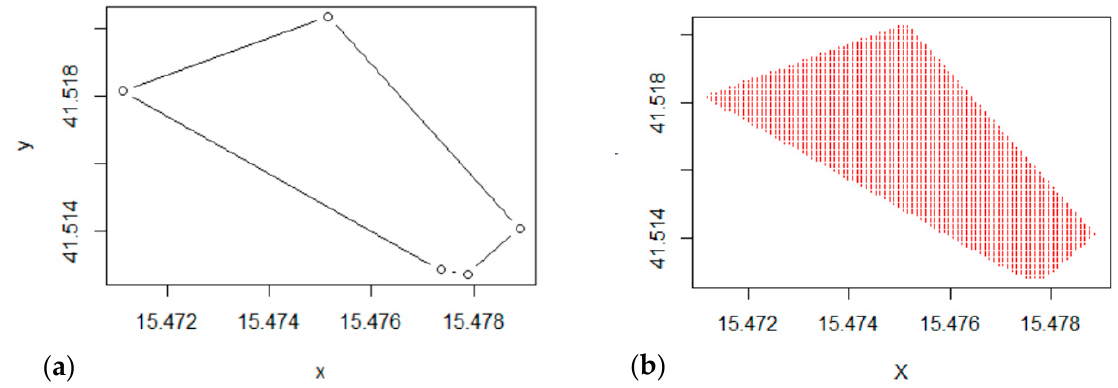
Figure 2. Boundaries of an experimental field ( a ); Regular grid 3 m × 3 m ( b ). The extract function of the “raster” package was used to extract the corresponding values from the raster of the spectral indices NDVI and MCARI2 and the glcm function of the homonymous package, to calculate the respective GLCM indices. These functions allowed to obtain a data frame in which in each row a point of the map (long, lat) was described with a column for the spectral index and a column for each GLCM index, for each date of the observed